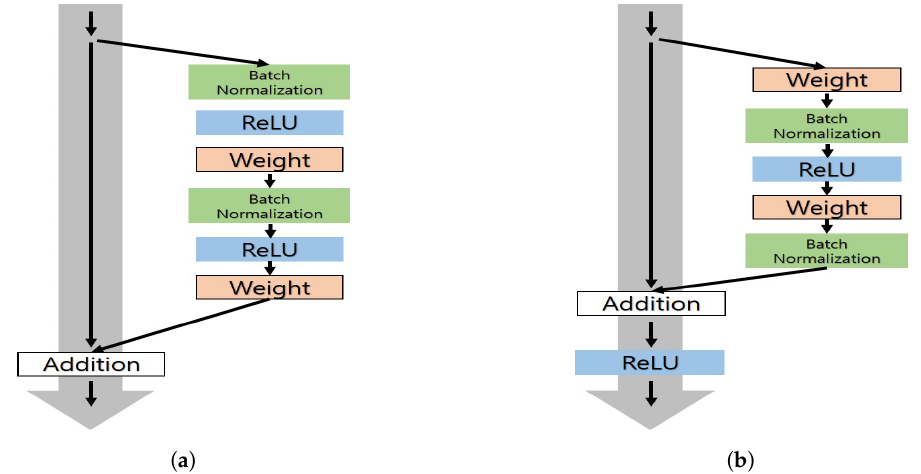
Figure 7. Comparison of ( a ) ResNet pre-act architecture and ( b ) original ResNet